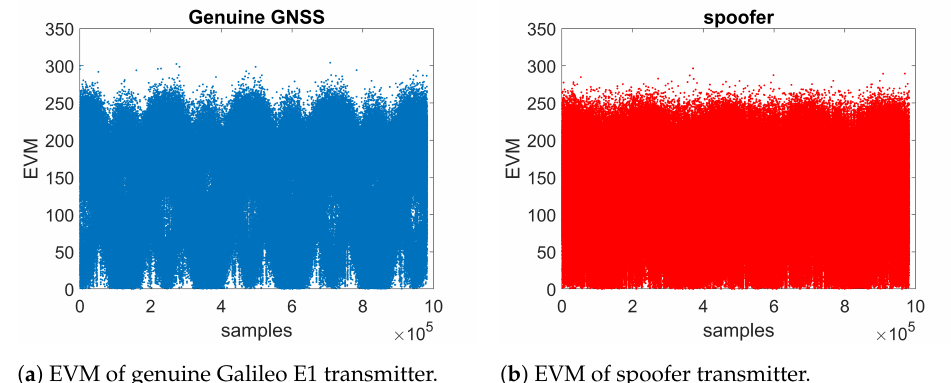
Figure 10. Illustrative example of EVM applied on pre-correlation data, in the absence of channel and receiver